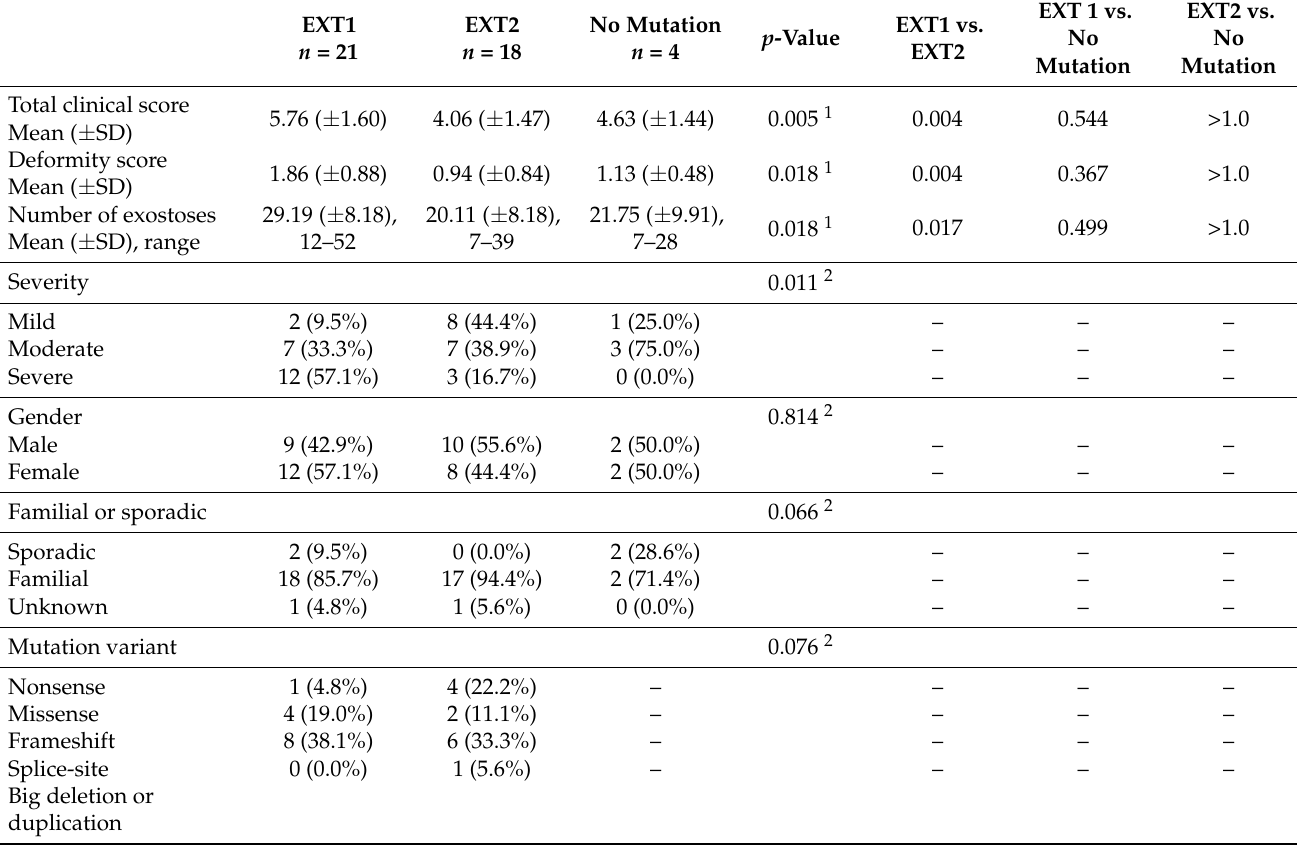
Table 2. Clinical assessment according to EXT1/EXT2 mutation.